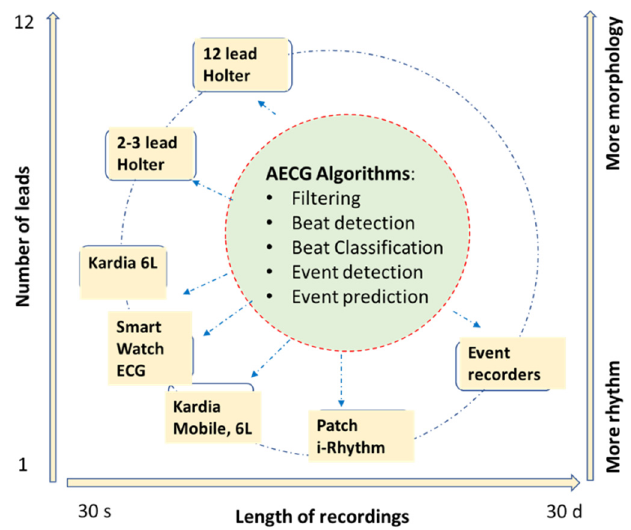
Figure 1. There are a wide range of AECG devices and applications. The recording length can be from 30 s to 30 days, and the number of leads of ECG can be from 1 to 12. At the center of all these lies the AECG algorithms including filtering, beat detection and classifications, and event detection and prediction. For devices with 1 or 2 leads, the events are mainly in rhythm abnormalities, such as sinus, AFIB, or tachycardia/bradycardia. For devices with more leads, some morphology analysis can be added such as ST, QT, LVH, or BBB.